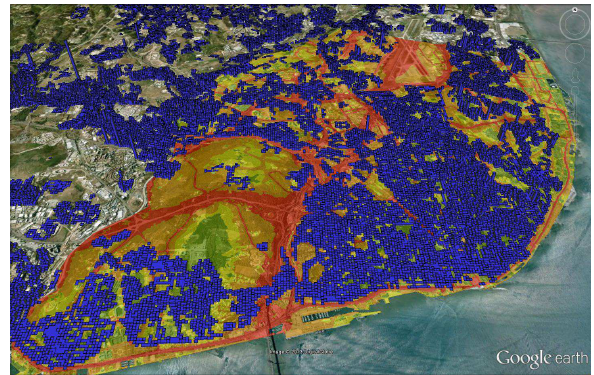
Figure 4. Nighttime noise (L n ) categories in 2009 and nighttime population (NP) density for Lisbon